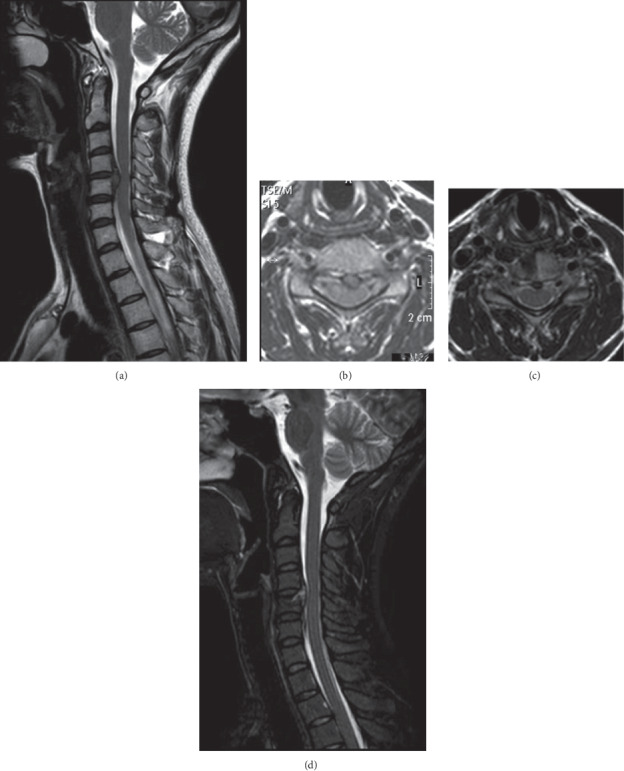
(a) T2-weighted sagittal magnetic resonance image (MRI) shows a central herniated disc behind the C5 vertebral body. (b) The axial MRI scan shows the herniated disc compresses the spinal cord and migrated downward. (c) Axial MRI after ATc-PECD (note the drilling tunnel in the C4 vertebral body). (d) Sagittal MRI after ATc-PECD shows a removal of the protruded nucleus pulposus.